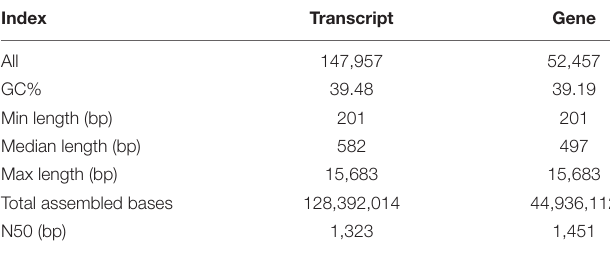
TABLE 1 | Summary of M. ruthenica transcriptome